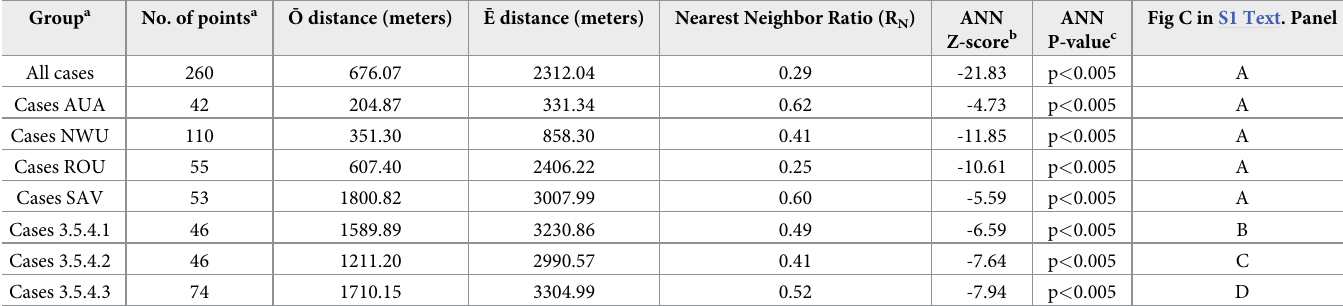
Table 2. Results of the Average Nearest Neighbor (ANN) statistic performed on geographic and phylogenetic groupings of S . Typhi acute infections. Group a No. of points a Fig C in S1 Text.